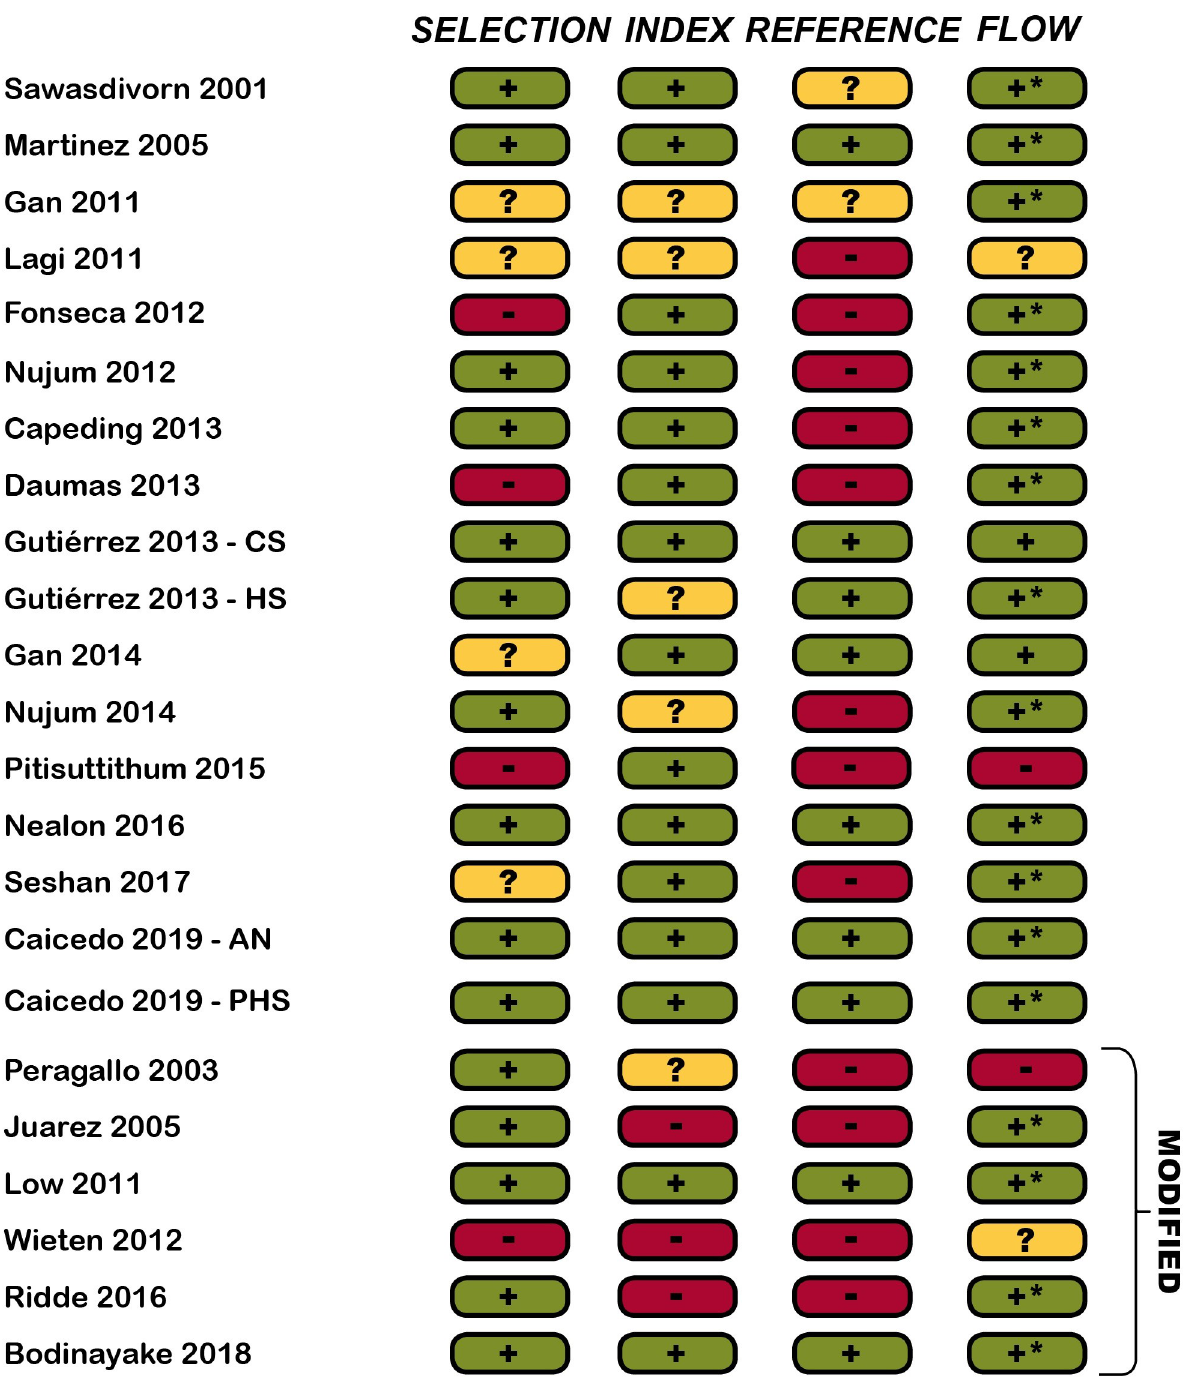
Fig 2. Risk of bias analysis for included studies assessing the diagnostic accuracy of clinical criteria for dengue fever. + (green): Low risk; + � (green): Withdrawals/indeterminate results not mentioned, assumed none and thus low risk;? (amber): unclear risk;—(red): high risk; CS: cohort study; HS: Hospital study; AN: Aedes Network study; PHS: Public Health Surveillance study. Modified refers to modifications from the 1997 or 2009 WHO criteria. The assessment was carried out by two independent reviewers (NR/SL) using a modified version of QUADAS-2 (S2 Table). A study was deemed to be at high risk of bias if any domain was at high risk of